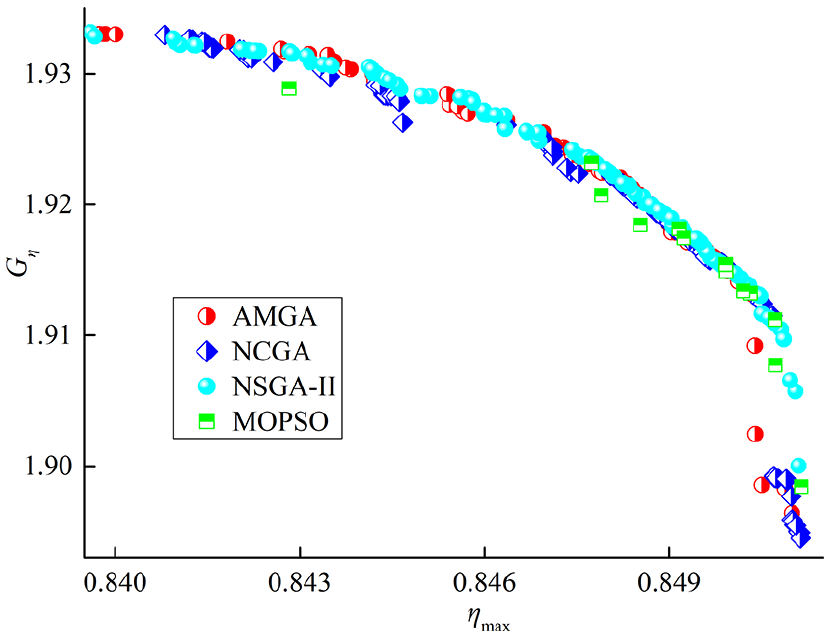
Figure 14. Comparison of Pareto front solution sets of different optimization algorithms. Table 4. Comparison of two objective optimization results of different optimization algorithms.